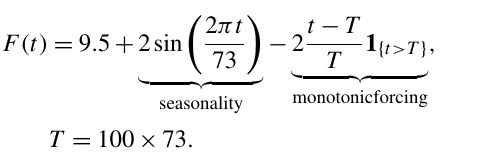
Figure 4. (a) Projection on axes (x,y) of the winter snapshot (red) and summer snapshot (blue). (b) Truncature at x 1 summer. (c) Combination of (a) and (b) (see designs ( T ), ( P ) and ( T T P computed with the Wasserstein distance. (g–i) box plots of distances between design T , P and T + distance. (d–i) White box plots differentiate between two winter snapshots. Grey box plots differentiates two summer snapshots. Black box plots compare winter and summer snapshots. Dotted lines represent the distance between winter and summer attractors (without designs) with N 10 6 =